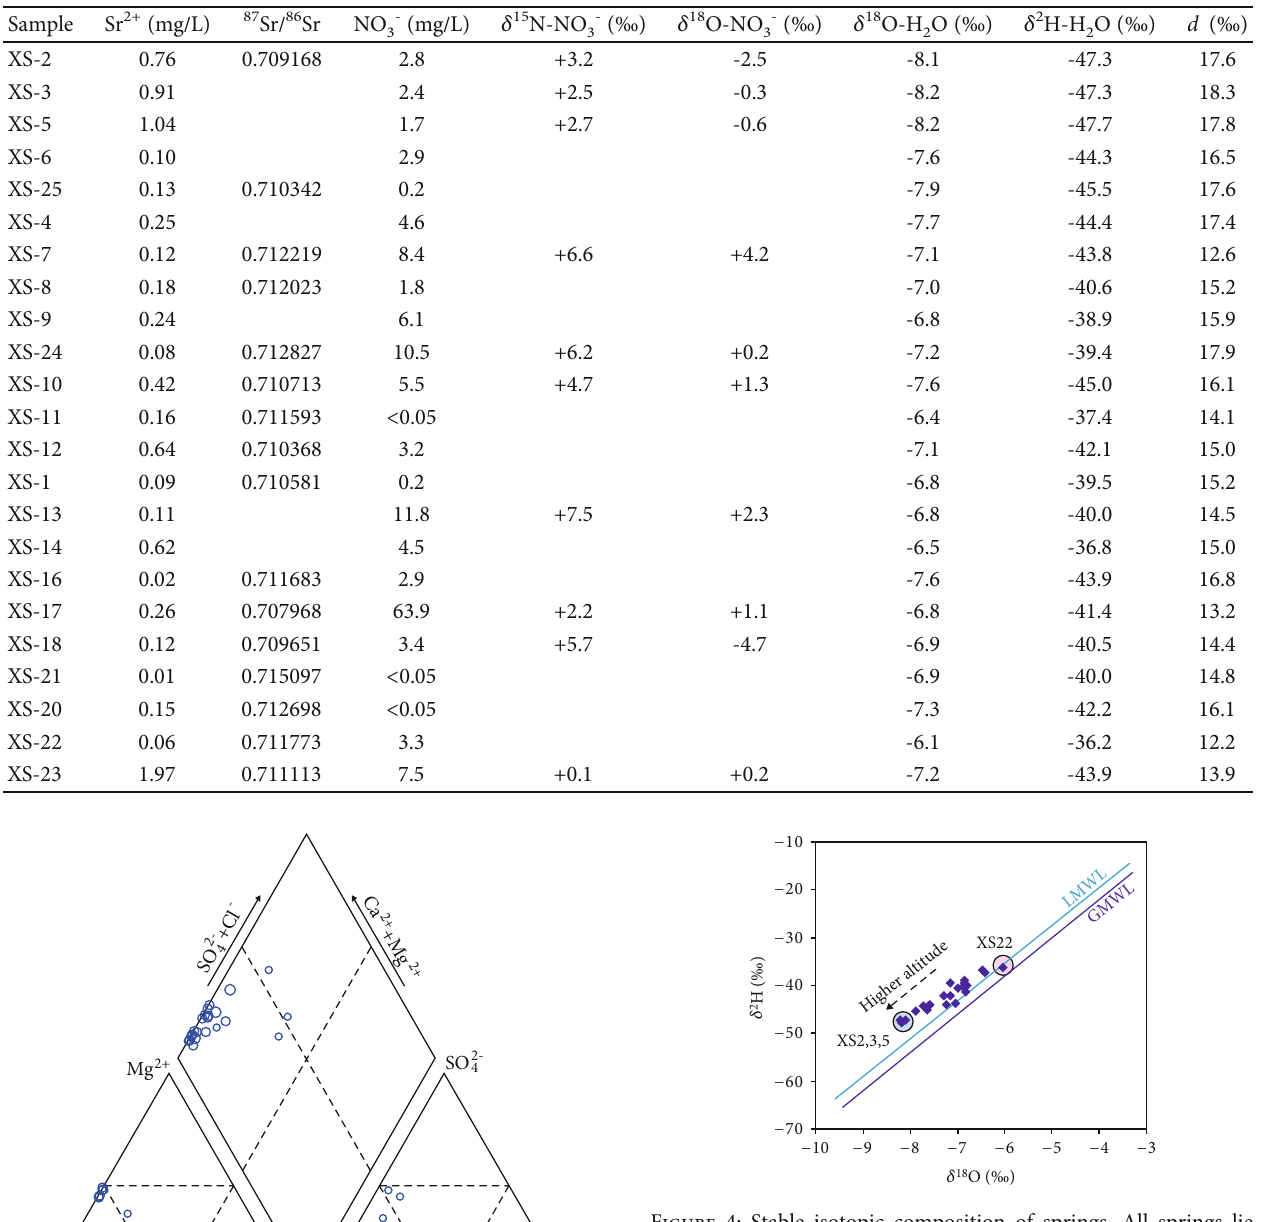
Table 3: Strontium and nitrate concentration and isotopic compositions for spring waters.